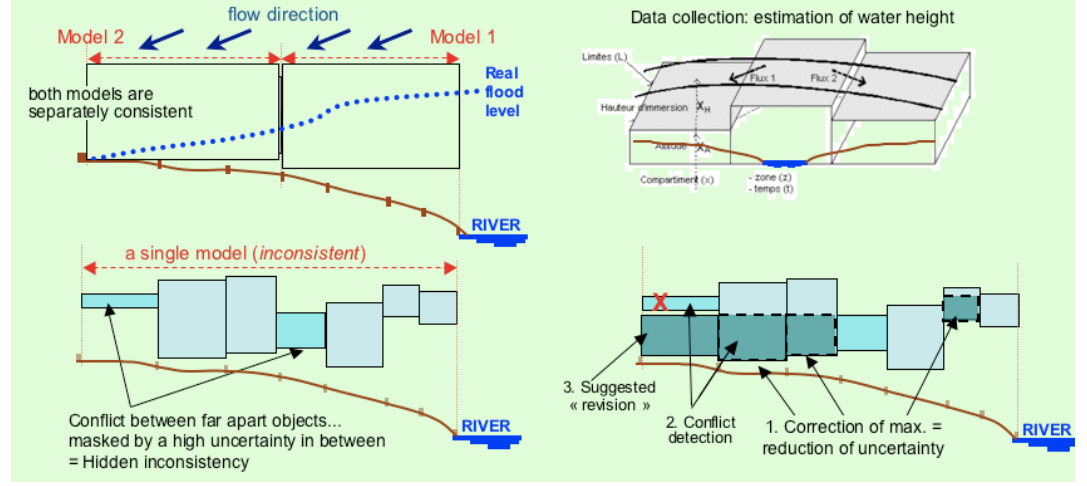
Figure 4. Estimation of a flooding event, combining two sources of data: flow direction ( top left ) and height (piecewise estimations: top right ). The bottom line sketches how inconsistencies can be detected between local models ( bottom left ), and then corrected into a unified model ( bottom right ).